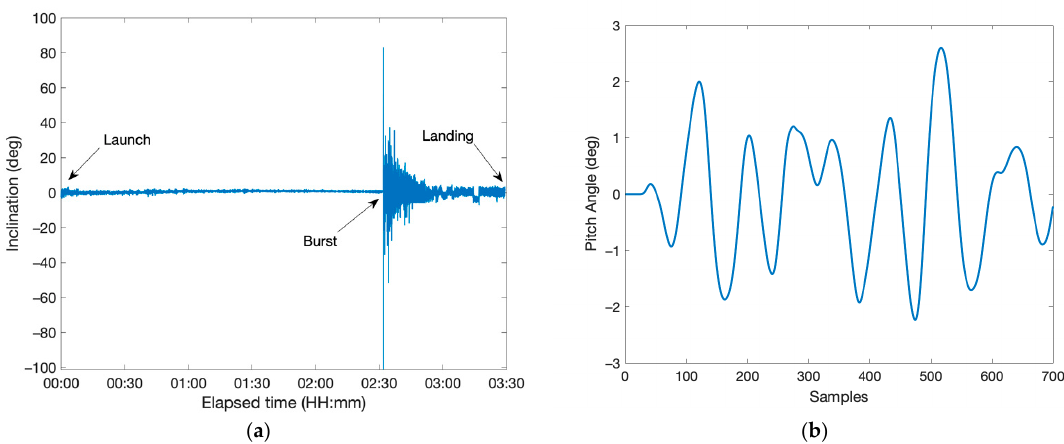
Figure 21. ( a ) Pitch oscillations vs. time registered by the IMU during flight ISM-HAB #3. ( b ) Low-pass filtered pitch oscillations signal at 27 km altitude.